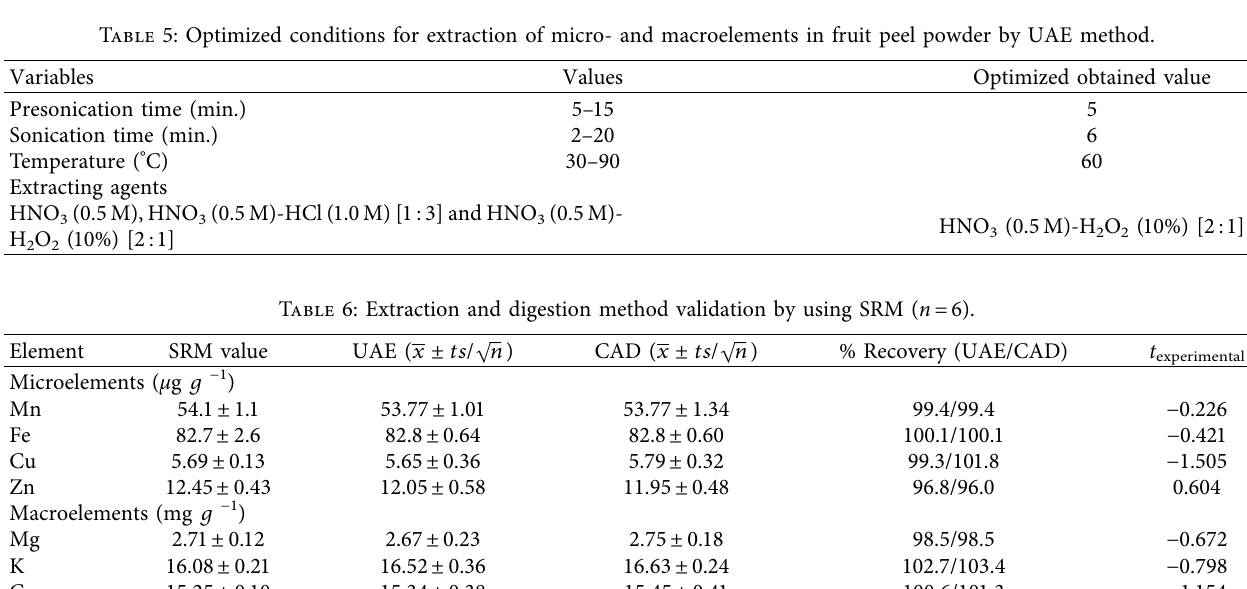
Set wavelength for peak searching (nm)